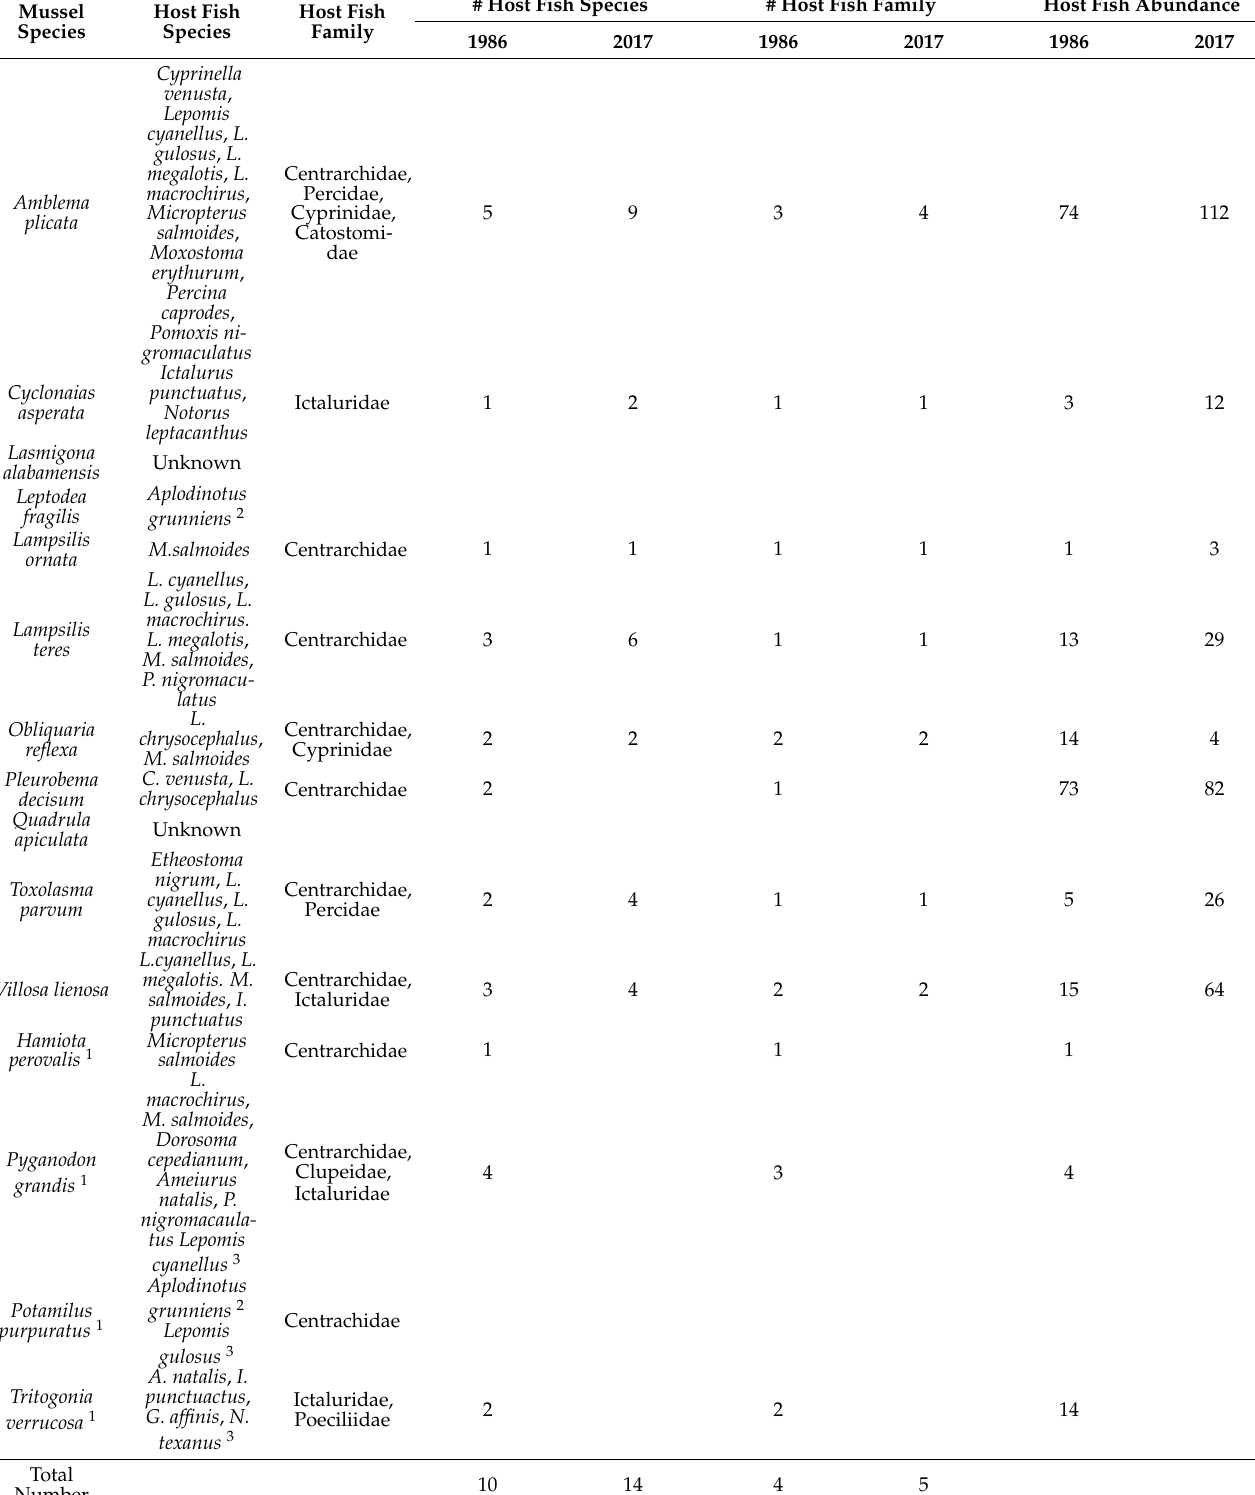
Table 4. Previously recorded (GSA/ADEM) number (#) of fish species and families and total abundance of fish that serve as host for freshwater mussels found in Bogue Chitto Creek surveys in 2019. 1 Indicates mussel species present only in 1994. 2 Host fish species were not present in Bogue Chitto surveys. 3 Indicates fish were only present in 2017